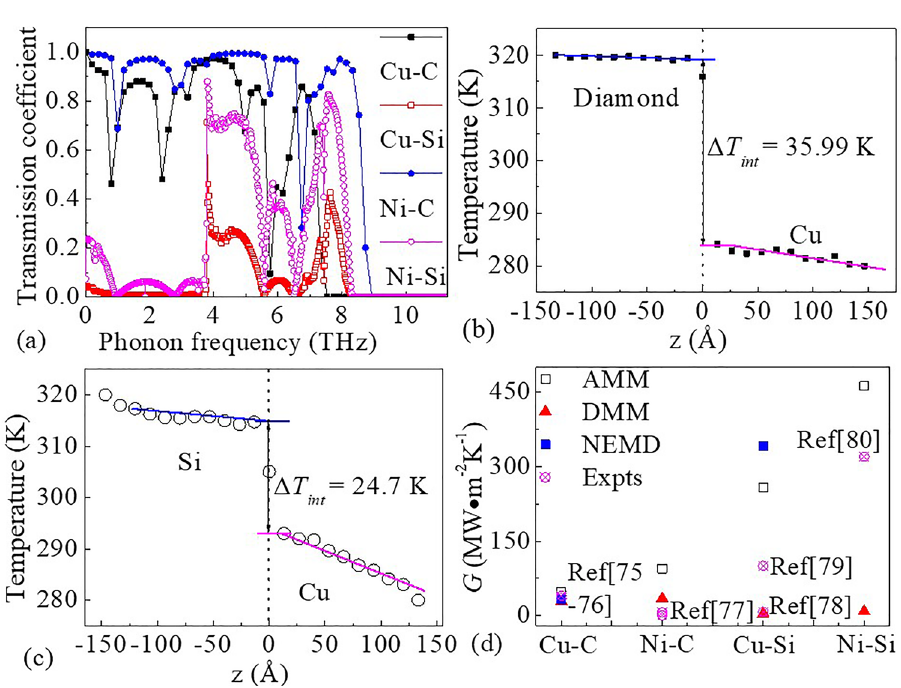
Figure 6. ( a ) Phonon transmission coefficients for the Cu–C, Ni–C, Cu–Si and Ni–Si interfaces. Temperature profile for the ( b ) Cu–C and ( c ) Cu–Si along the direction of z at room temperature. ( d ) Interface thermal conductance ( G ) for the Cu–C, Ni–C, Cu–Si and Ni–Si interfaces. The experimental data from Refs. 75–80 are also shown for